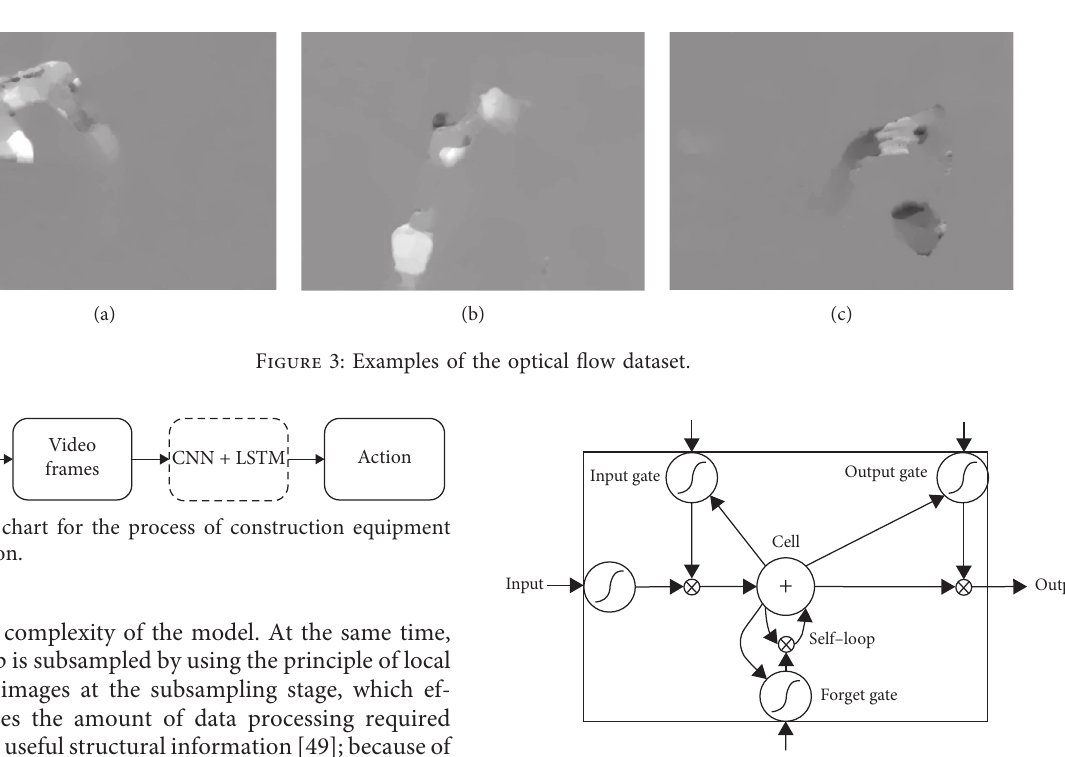
Figure 5: Cell structure in long short-term memory